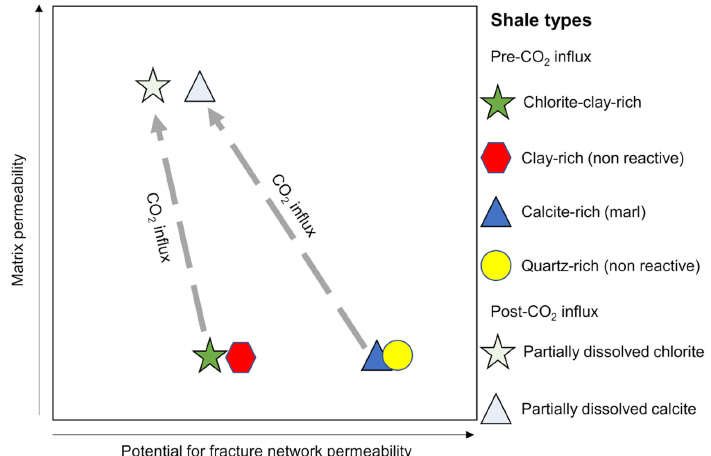
Figure 21. Conceptual model for the potential dynamic permeability changes resulting from CO 2 influx for four theoretical shale types: (1) chlorite-rich shale, (2) smectite-illite-kaolinite